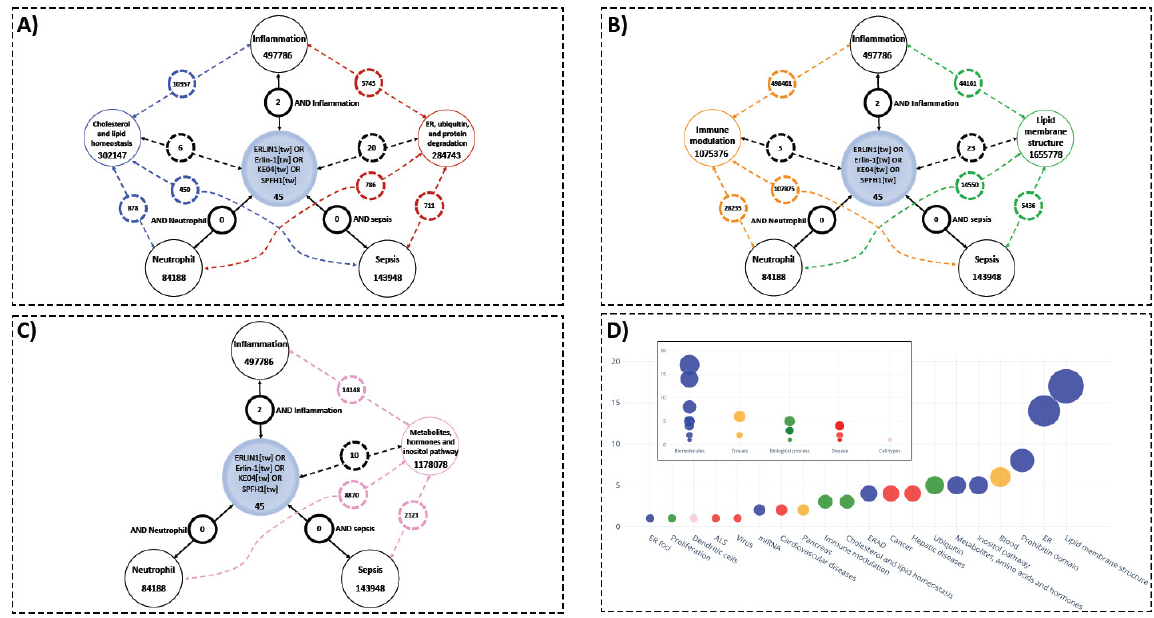
Figure 2. Knowledge gaps concerning ERLIN1, key biological concepts, and PubMed literature on sepsis, inflammation, and neutrophils demonstrate potential novel roles of ERLIN1 in the pathogenesis of sepsis. ( A – C ) The available literature used to infer potential roles for ERLIN1 expression in immune cells during sepsis through ER-mediated protein degradation, cholesterol homeostasis, and signaling events via lipid structures and inositol pathways. Results of literature search for ERLIN1 (and aliases) and the terms sepsis, inflammation, and neutrophils in humans are enclosed in black circles; the numbers represent the article count retrieved for each association. The PubMed search results with the key biological concepts (colored circles) and literature on sepsis, inflammation, and neutrophils are depicted with dotted lines of corresponding colors. ( D ) Functional grouping of the title terms from the PubMed query on ERLIN1. The extracted terms were manually assembled into 20 representative functional groups (main graph), and then further condensed to a final list of five key biological concepts for subsequent search strategies.